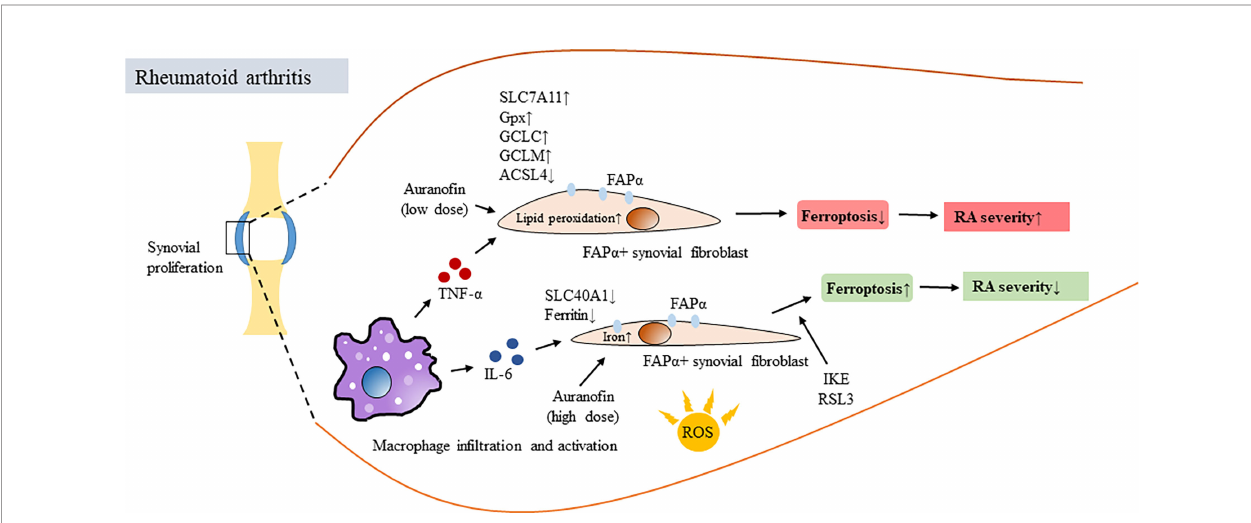
FIGURE 2 | Ferroptosis of synovial fi broblasts in RA and its association with disease activity. Oxidative stress resulted in increased production of ROS, induced proliferation of synovial fi broblasts and caused synovitis and joint destruction in patients with RA. In synovial space, in fi ltrating macrophages produced proin fl ammatory cytokines such as TNF- a and IL-6, both are critical in mediating RA pathogenesis. However, TNF- a and IL-6 have different roles in regulating ferroptosis. TNF- a provided survival signal for fi broblast activation protein- a (FAP) a + fi broblasts in synovial areas close to in fi ltrating macrophages, exaggerated synovial in fl ammation and increased RA disease activity. This was done by activating or inducing several regulators associated with GSH biosynthesis, including SLC7A11, GSH, NF- k B, GCLC, GCLM and reducing ACSL4 in ferroptosis-resistant FAP a + fi broblasts. In contrast, IL-6 increased intracellular iron levels, decreased the expression of SLC40A1 and ferritin and resulted in inducing ferroptosis of synovial fi broblasts. Aurano fi n differential regulated ferroptosis depending on the dosages of administration. IKE and Gpx4 inhibitor RSL3 treatment induced ferroptosis, downregulated numbers of FAP a + fi broblasts and reduced severity of synovitis. TNF- a , tuor necrosis factor alpha; IL-6, interleukin-6; FAP, fi broblast activation protein; Gpx4, glutathione peroxidase 4; SLC7A11, solute carrier family 7 member 11; GSH, glutathione; GCLC, a glutamate-cysteine ligase regulatory subunit; GCLM, a glutamate-cysteine ligase catalytic subunit; SLC40A1, solute carrier family 40 member 1; IKE, imidazole ketone erastin; RSL3, RAS synthetic lethal